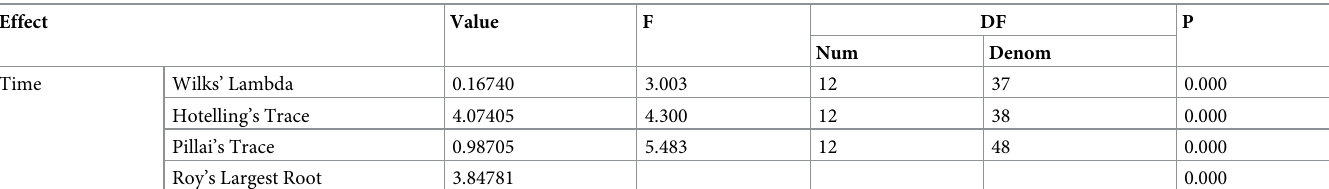
Table 4. Repeated measures MANOVA to identify significant variation in time.